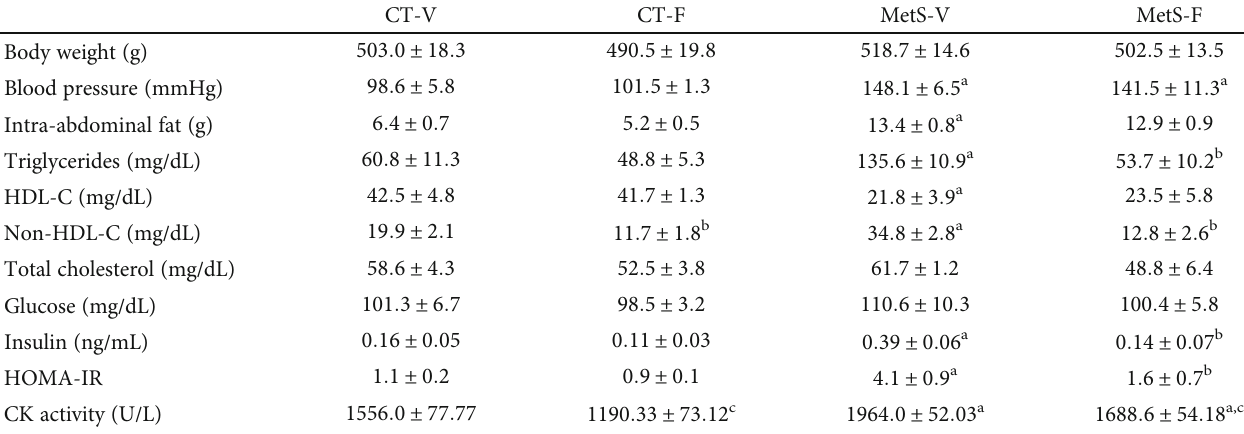
Table 1: The e ff ects of feno fi brate administration on body characteristics and biochemical parameters from the control (CT) and MetS rats. CT-V CT-F MetS-V MetS-F Body weight (g)